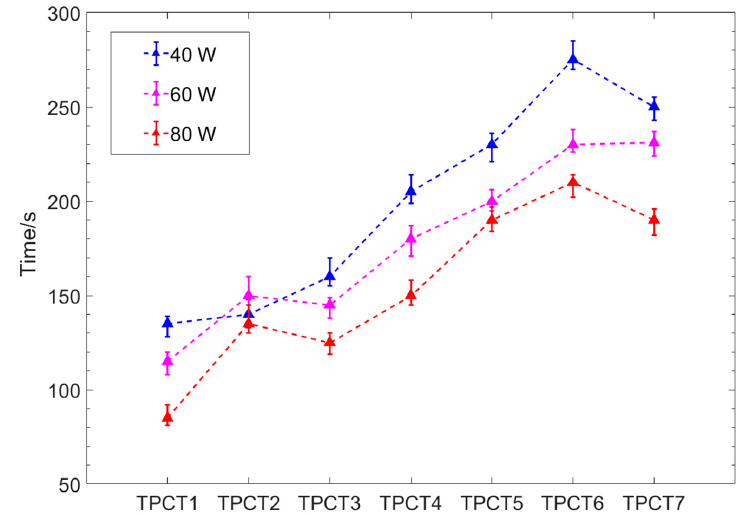
Figure 7. Times taken by the average evaporator temperatures of TPCT1–TPCT7 to stabilize at different input powers with various wettabilities on evaporator